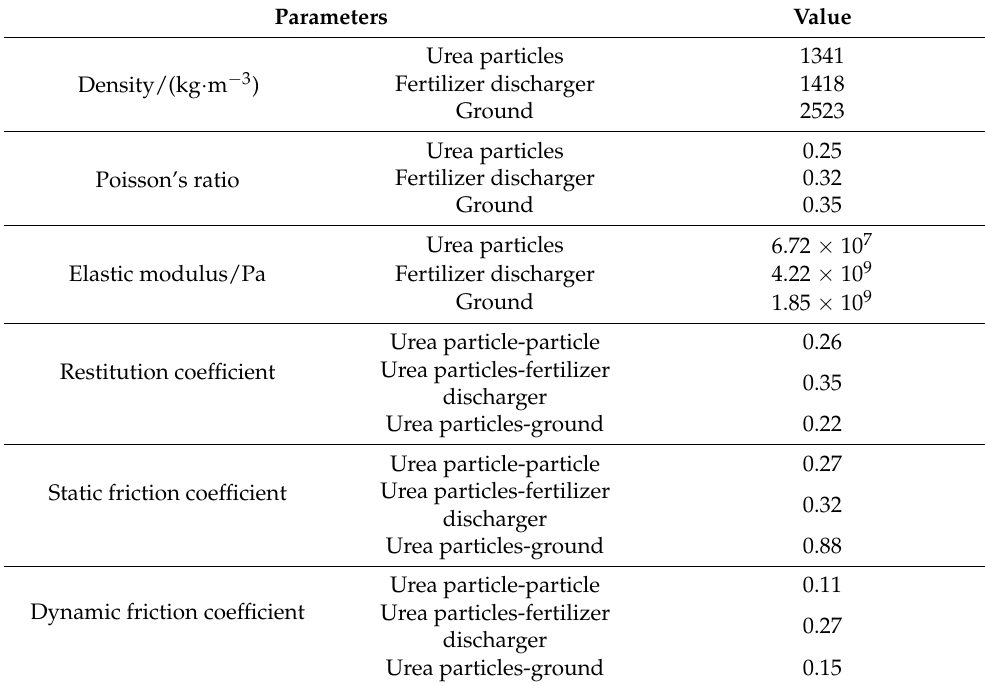
Table 2. Simulation test